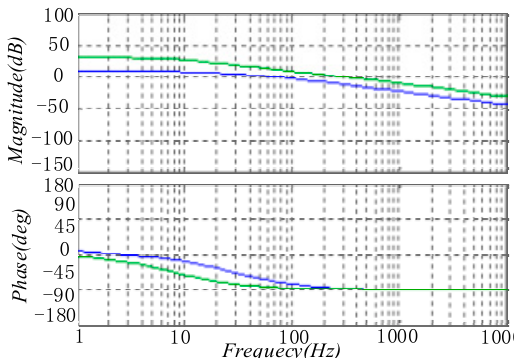
Figure 17. Bode diagram of front stage output impedance and back stage input impedance.